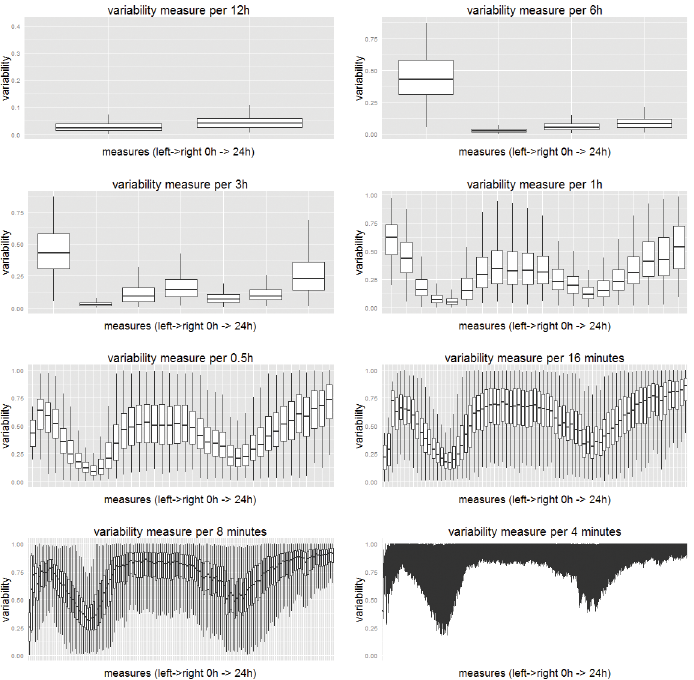
Fig 4. Variability of regularity in the trip matrix over time. Note: Each box plot shows the variability of 400 stations over time measured at different temporal scales. Overall, eight subplots give a similar trend where lower variability appears during peak hours (around 9 am in the morning and 6pm in the evening). More details can be captured as differences of variability between each time unit are magnified as we decrease the temporal scale from 12h to 4